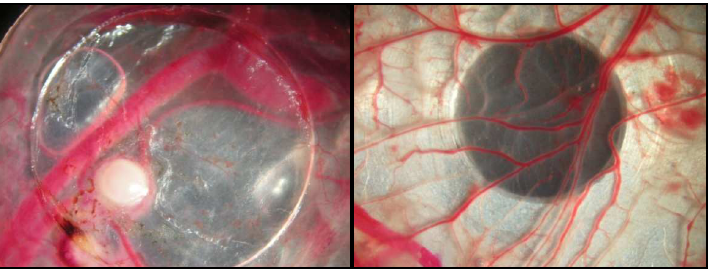
Figure 5. Tumor tissue with vascularisation on ring (left), CAM on aluminium target